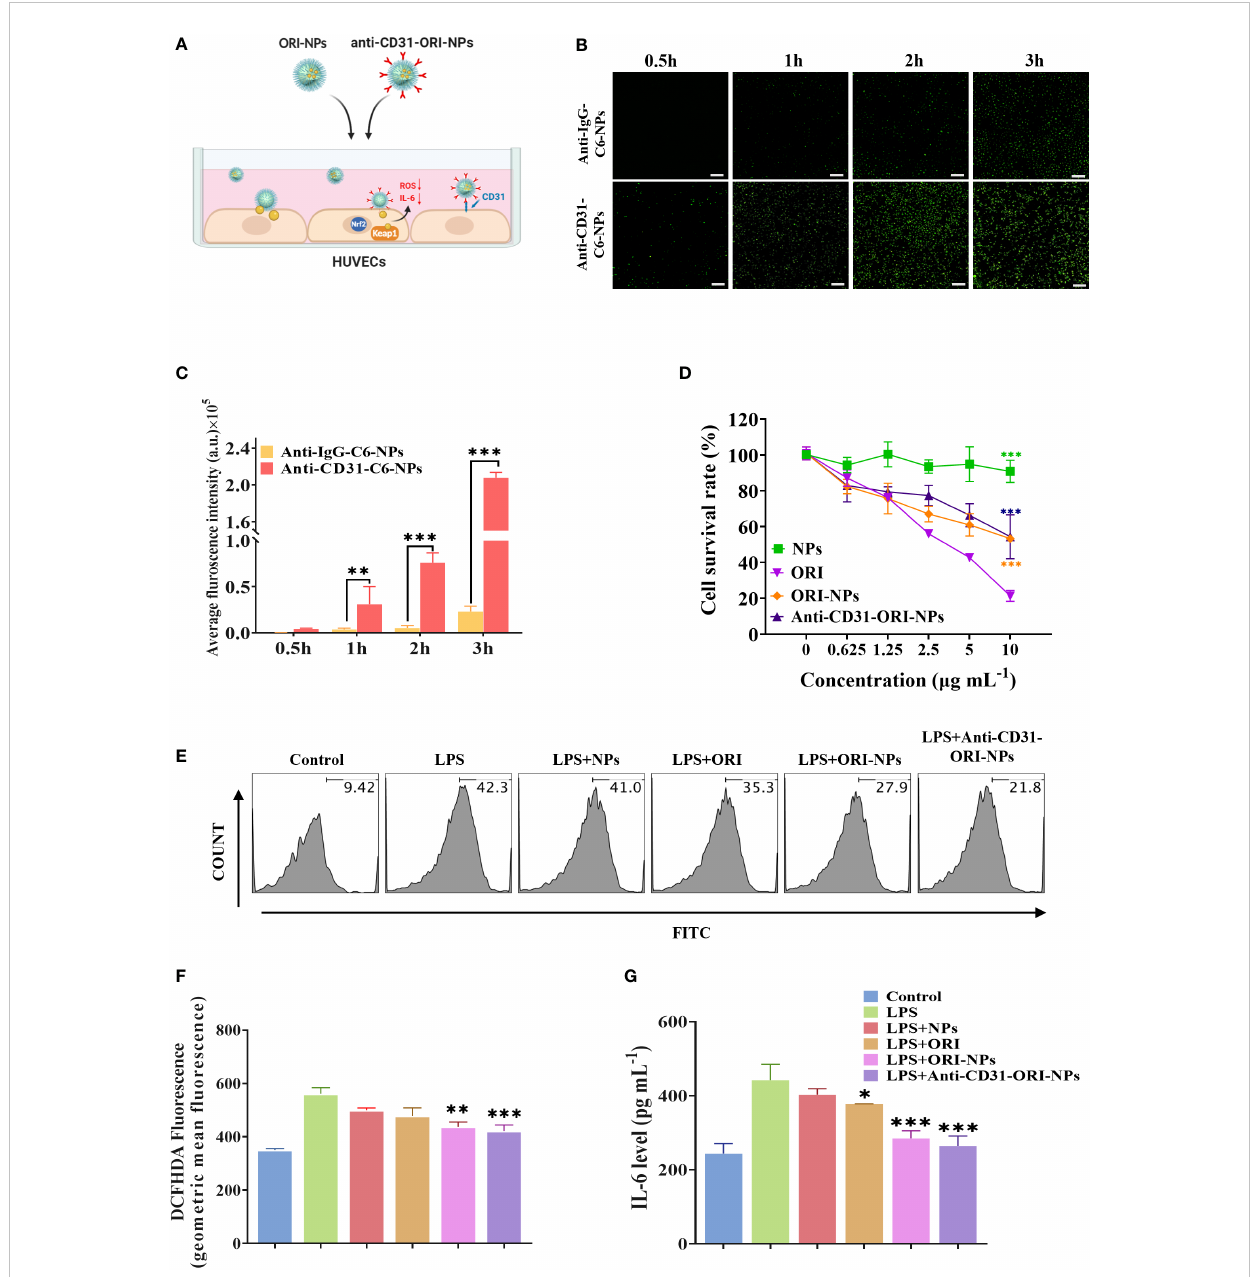
FIGURE 3 Anti-CD31-ORI-NPs enhanced anti-in fl ammatory effect of ORI via targeting to the endothelial cells (A) HUVECs were pretreated with 2 m g mL -1 blank NPs, ORI, ORI-NPs, anti-CD31-C6-NPs or anti-IgG-C6-NPs. (B, C) Cellular uptake of anti-CD31-C6-NPs and anti-IgG-C6-NPs in HUVECs was observed by fl uorescence microscopy. The fl uorescence intensity was analyzed and quanti fi ed. Bars: 1 mm. *** p < 0.001, compared to anti-IgG-C6- NPs group. (D) HUVECs were incubated with indicated treatments for 24 hours. The cytotoxicity was analyzed by MTT assay. *** p < 0.001, compared to the ORI treatment group. (E – G) The effects of NPs, ORI, ORI-NPs and anti-CD31-ORI-NPs on ROS and IL-6 production. HUVECs were pretreated with 2 m g mL -1 NPs, ORI, ORI-NPs, anti-CD31-ORI-NPs, and then stimulated with 1 m g mL -1 LPS. ROS and IL-6 production was evaluated by fl ow cytometry and ELISA, respectively. * p < 0.05, ** p < 0.01 and *** p< 0.001, compared to the LPS-stimulated group. Data were representative three independent experiments and expressed as mean ±